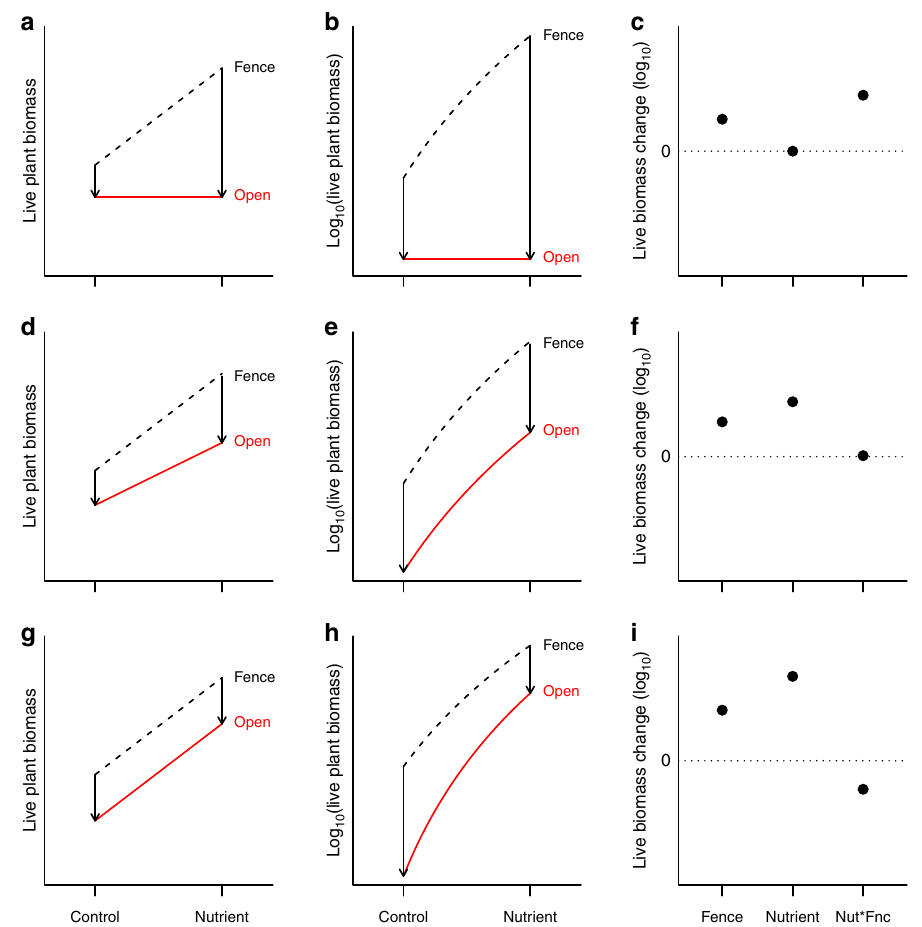
Fig. 1 Predictions for plant biomass with increasing environmental productivity. Arrows indicate the predicted difference in biomass at ambient (Control) and elevated (Nutrient addition) productivity in the presence (Open) and absence (Fence) of herbivores. Predictions for plant mass with increasing productivity when herbivores a consume all additional biomass produced (see ref. 24 ); d consume a constant proportion of biomass (see ref. 29 ); g consume a constant amount of biomass. Panels b , e , h show these predictions for log(biomass). Panels c , f , i show the difference (arrow lengths (fence and nutrient) and difference of arrow lengths (Nut*Fnc) in b , e , h ), and visualize these hypotheses as they would look in the factorial experimental